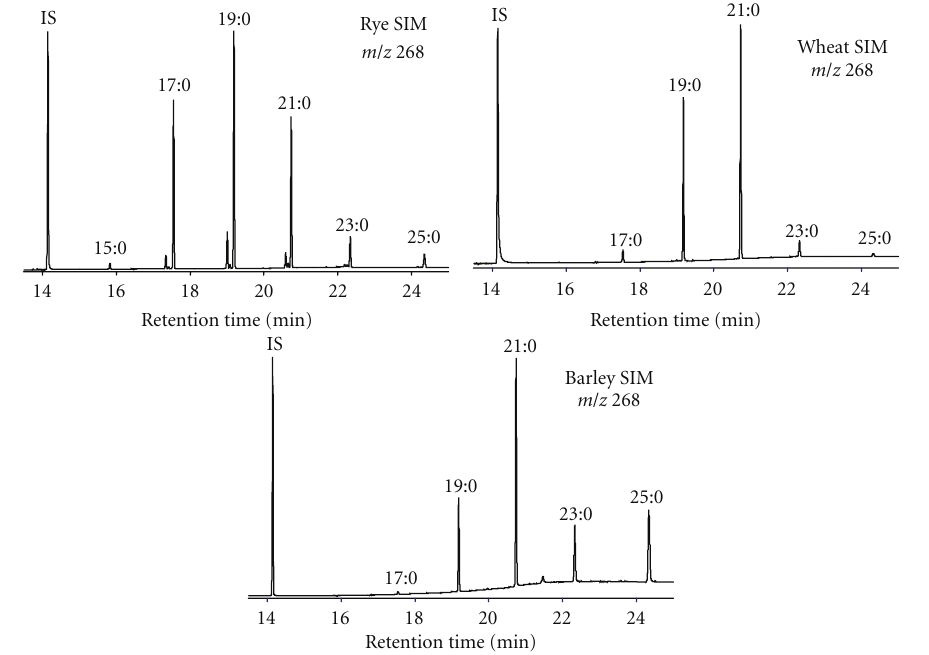
Figure 2: GC-MS chromatograms of the main AR containing cereals: wheat, rye, and barley. The ratio of the di ff erent odd-numbered saturated homologues varies from grain to grain but is generally conserved from variety to variety. The ratio C17:0/C21:0 can be used to determine if a cereal sample is wheat ( ∼ 0.1) or rye ( ∼ 1.0) and is reflected partially in